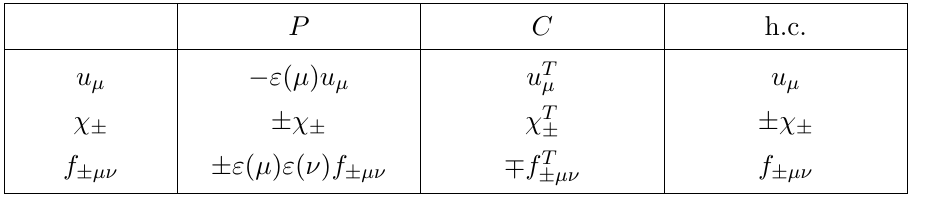
Table 2 . Transformation properties of the main chiral building blocks, where " (0) = (cid:0) " ( i = 1 ; 2 ; 3) =